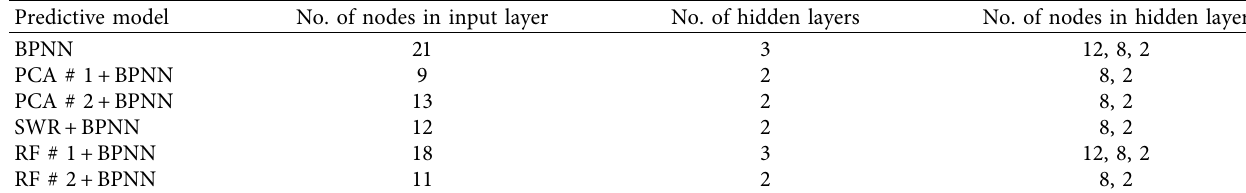
Table 3: The parameter structure of the BPNN predictive